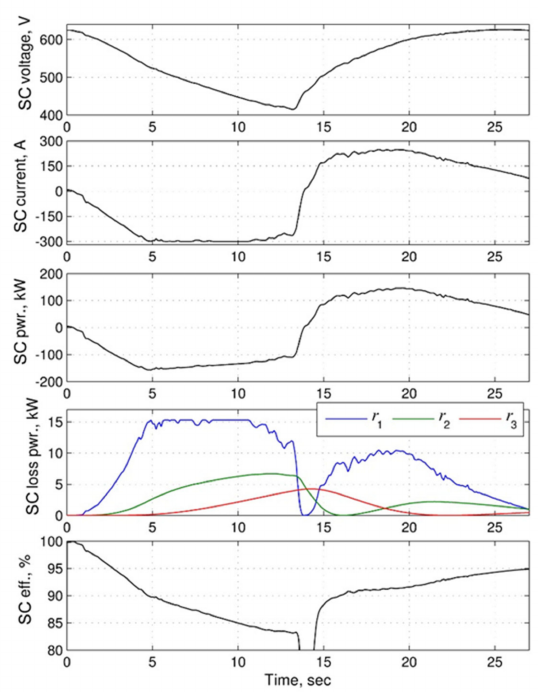
Figure 8. Model analysis of the power losses and e ffi ciency of the